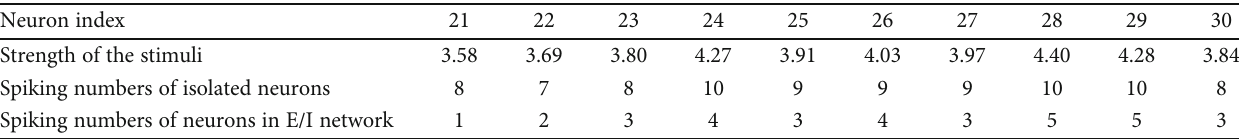
Spiking numbers of neurons in E/I